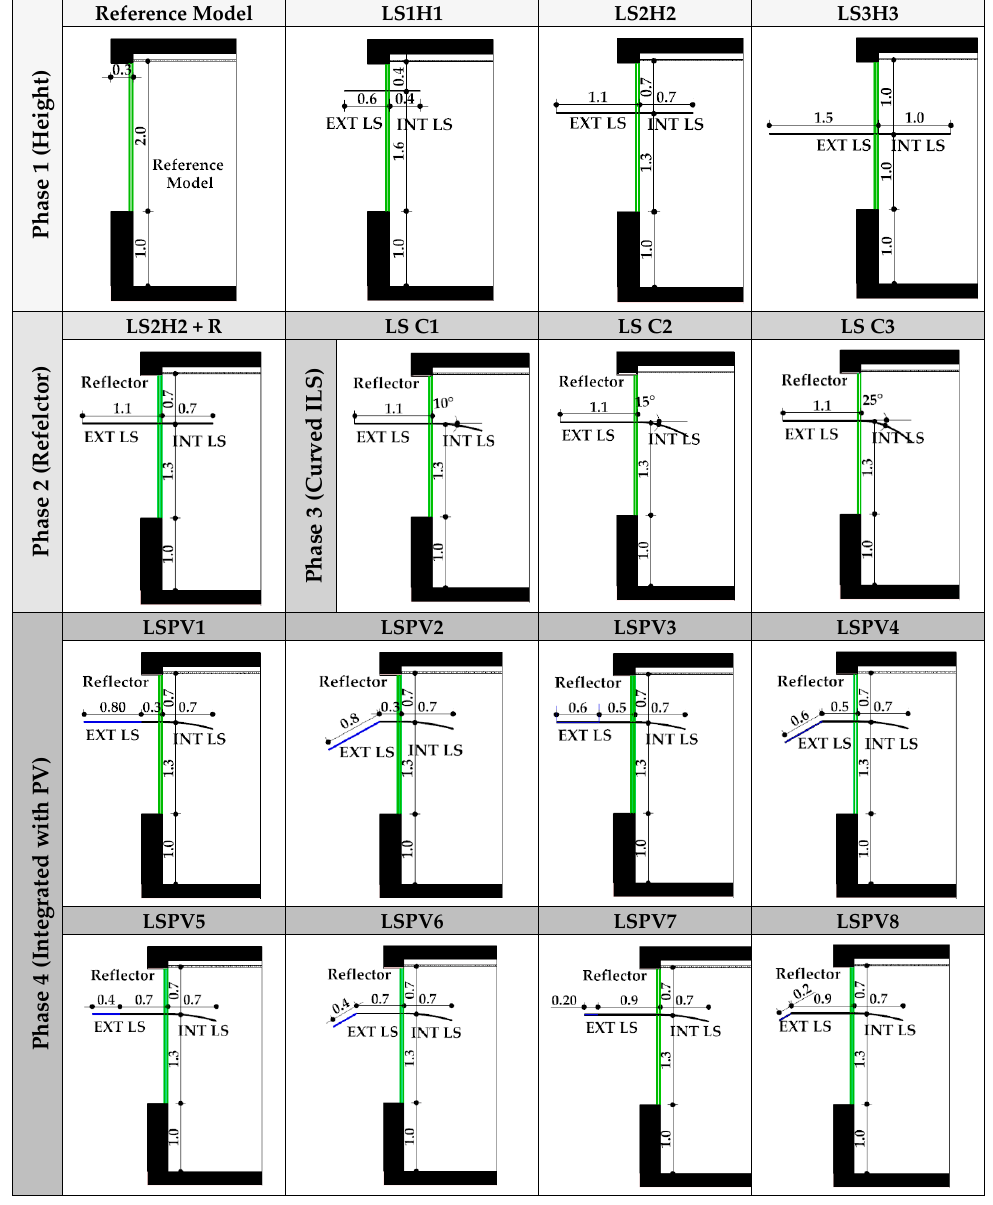
Table 2. Light shelf configurations used in simulation for each phase.